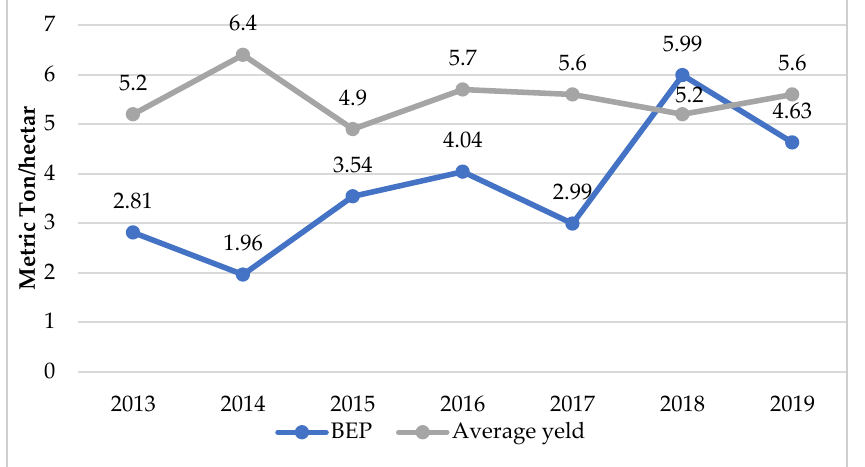
Figure 4. Break-even yield (Ton/ha) of durum wheat on sample farm.